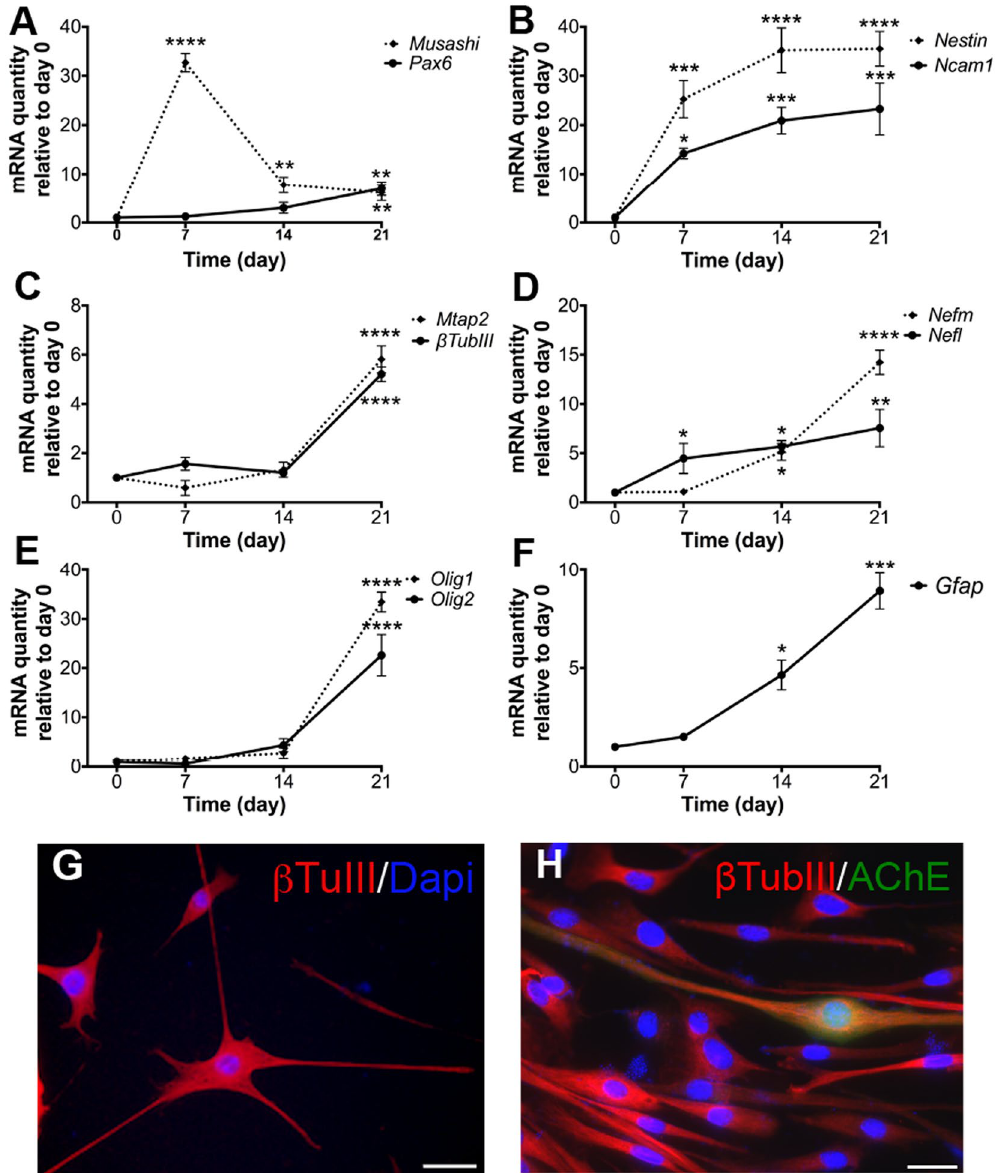
Figure 4. Induced neuronal differentiation of iMuSCs. ( A–F ) Gene expression kinetics were analyzed by qPCR during the 21-day neuronal differentiation period of the plated iMuSC-formed neurospheres. Data are presented as ± SEM of five biological replicates. * P < 0.05, ** P < 0.01, *** P < 0.001, **** P < 0.0001. ( G , H ) Immunocytochemical staining of neurons after 21-day differentiation from iMuSC-formed neurospheres. β -Tubulin III (red, G , H ) and AChE (green, H ). Nuclei were stained with DAPI. Scale bar = 100 µ m ( G ) and 10 µ m ( H